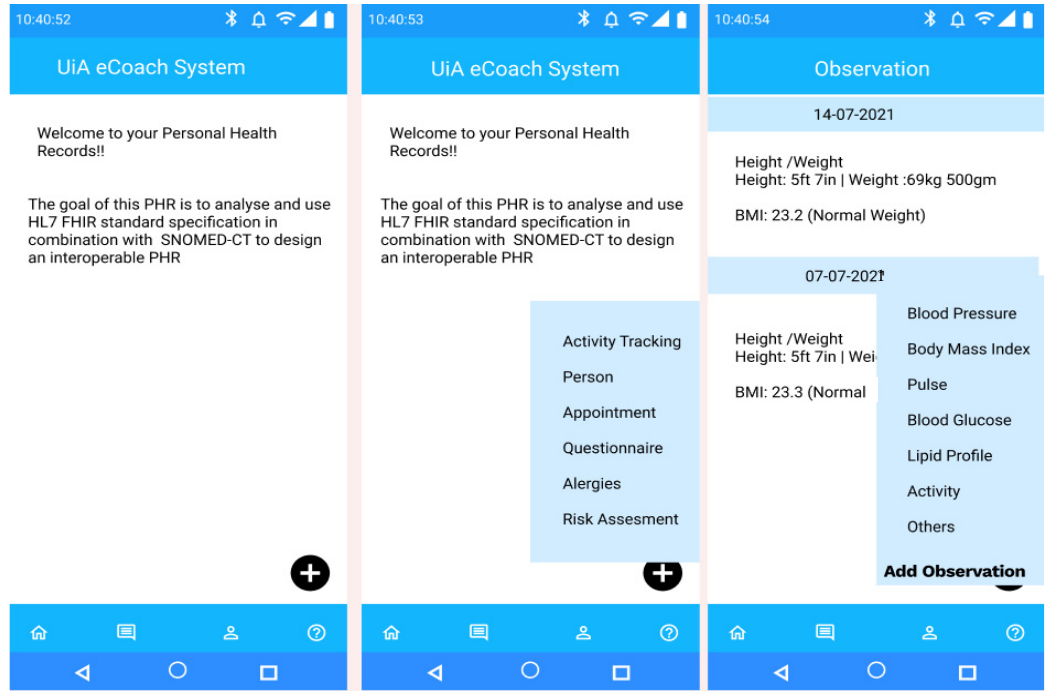
Figure 2. The client-server architectural view of tethered PHR solution with HL7 FHIR and SNOMED-CT.